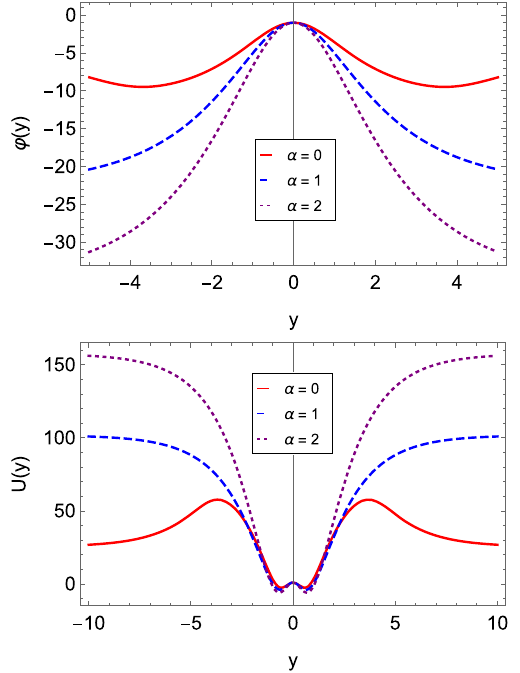
Fig. 5 Numerical solutions for ϕ( y ) (top panel) and U ( y ) (bottom panel) from Eqs. (40) and (41) with ϕ 0 = − 1, U 0 = k = φ 0 = 1, for different values of